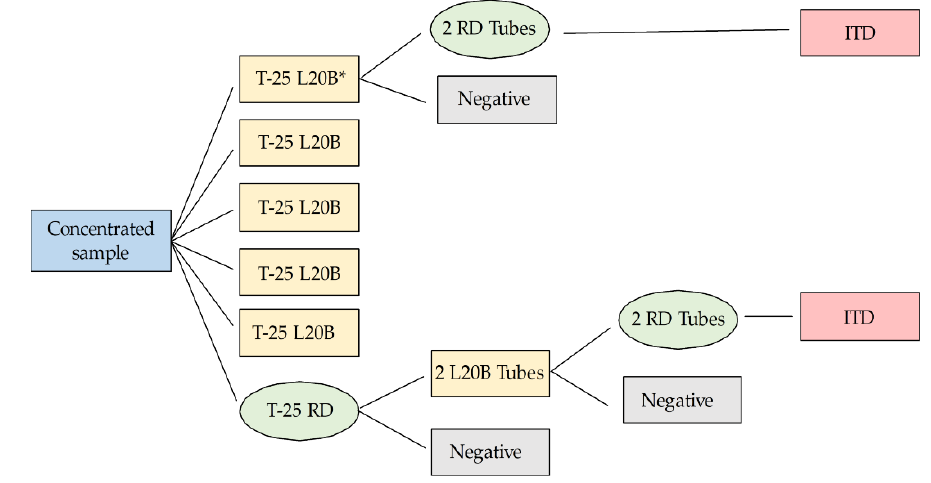
Figure 1. Flowchart of poliovirus isolation protocol. This is an alternative test algorithm for poliovirus isolation and characterization, which is an adaptation of the World Health Organization (WHO) guidelines for environmental surveillance of poliovirus circulation [14]. *All five 25 cm 2 flasks containing monolayers of L20B cells (that were not to be pooled for freezing) followed the same path. Tubes were pooled together.